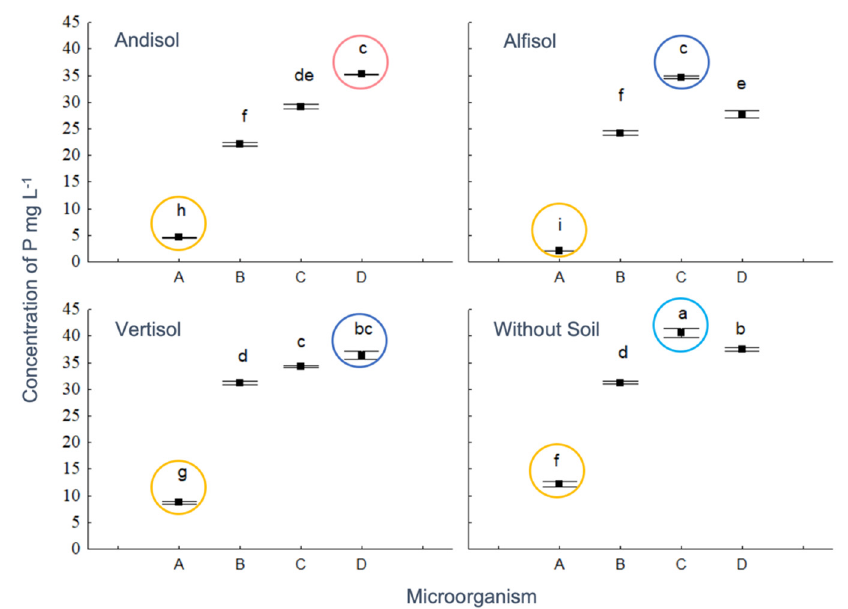
Figure 6. E ff ect of the interaction of soil and fungal isolate on P content, having PC1 and PC2 as covariates, which were not significant. Circles indicate the microorganisms in the x-axis: A: BMH-0059, B: BMH-0060, C: BMH-0061, D: BMH-0062. Di ff erent letters denote statistically significant di ff erences ( p < 0.05)